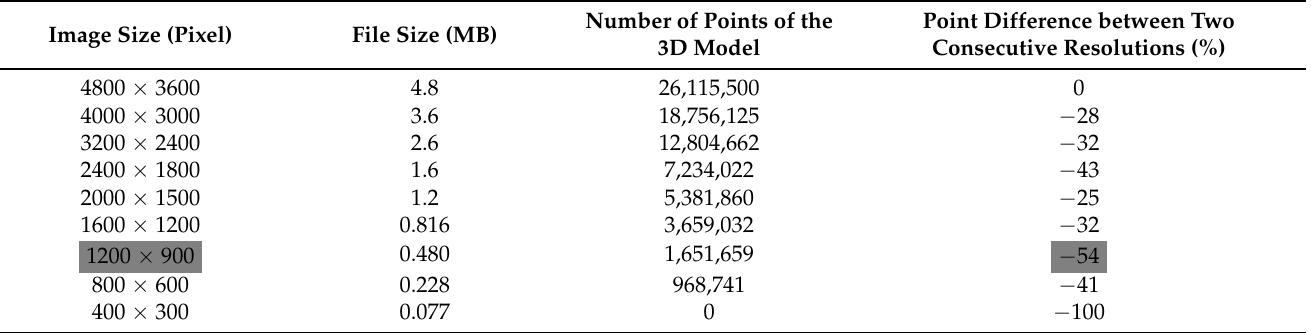
Table 1. The number of points obtained for the 3D model according to both image size (expressed in pixel) and image file size (expressed in MB). This test was carried out along the river, with 11 images taken at a distance of 3 m between each other.